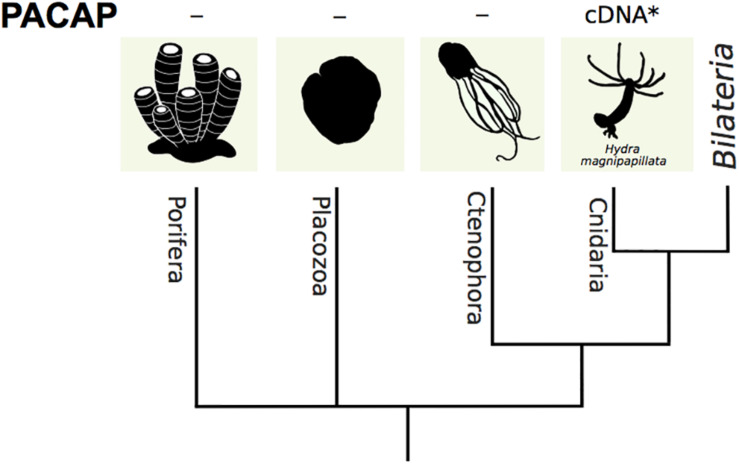
A dendrogram representing the phylogenetic relationship of non-bilaterian phyla. A partial PACAP cDNA was isolated from the Hydra magnipapillata. In other non-bilaterian phyla the existence of PACAP remains to be established (-). The evolutionary relationship between the species was based on (Brunet and King, 2017).